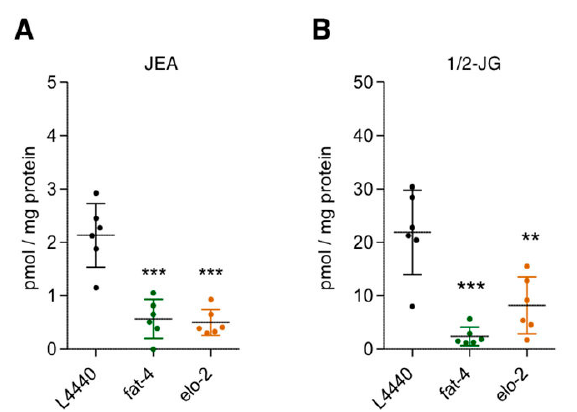
Figure 9. Reduction in the levels of EC like molecules in fat-3 ( wa22 ) after knockdown of fat-4 and elo-